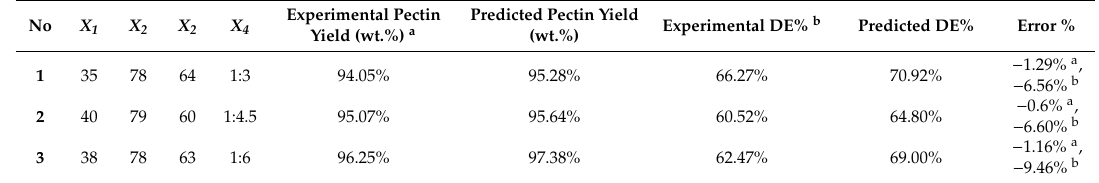
Table 6. Suggested validation parameter for obtaining the maximum pectin yield and DE% during extraction using ChCl–Mal.